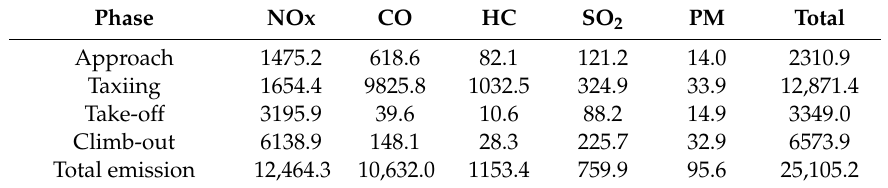
Table 5. Aircraft emissions in the GBA airports in 2017 during di ff erent LTO operation phases